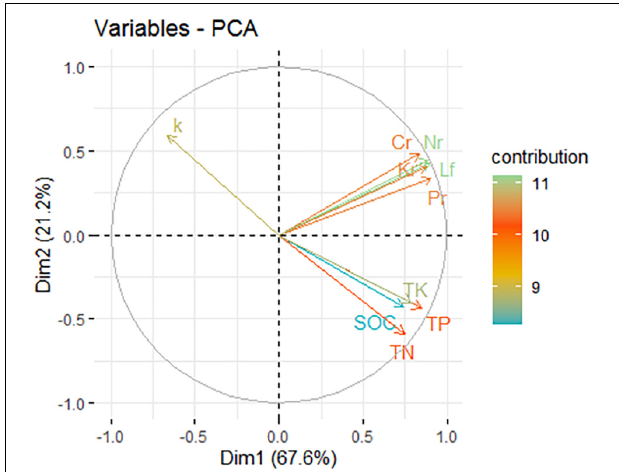
FIGURE 4 | Principal component analysis of variables. The arrow line of the variables is plotted as the correlation coefficients between them and the first two principal components in the unit circle; colors indicate the contributions (%) of variables to the variance in a given principal component. SOC, soil organic carbon; TN, total nitrogen; TP, total phosphorous; TK, total potassium; Lf, annual litter yield; Cr, C return through litter in a year; Nr, N return through litter in a year; Pr, P return through litter in a year; Kr, K return through litter in a year; k, annual decay